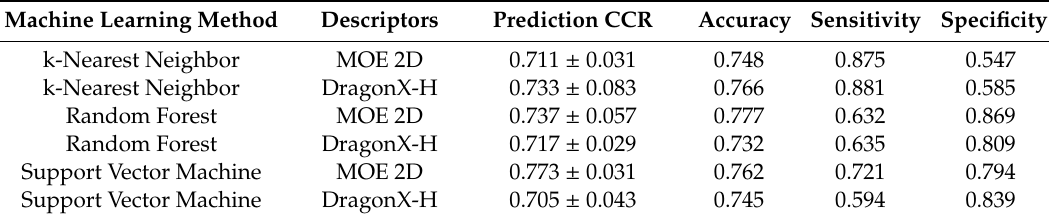
Figure S1. The ligand dataset was split into 128 active and 106 inactive molecules based on the compounds’ activity data reported in the respective literature (Supplementary Table S1). The QSAR models were constructed using three di ff erent algorithms: k-Nearest Neighbor (k-NN), Random Forest (RF), and Support Vector Machine (SVM). The chemical characteristics of each molecule were represented by either DragonX-H or MOE descriptors. The three QSAR methods (k-NN, RF, and SVM) resulted in predictive models that satisfied the statistical threshold Q 2 or the correct classification rate (CCR) of 0.7 (Table 1), which are the acceptable criteria for a reasonable prediction. Table 1. Summary of QSAR models considered in the current study for identifying the TLR3 / 7 / 8 / 9